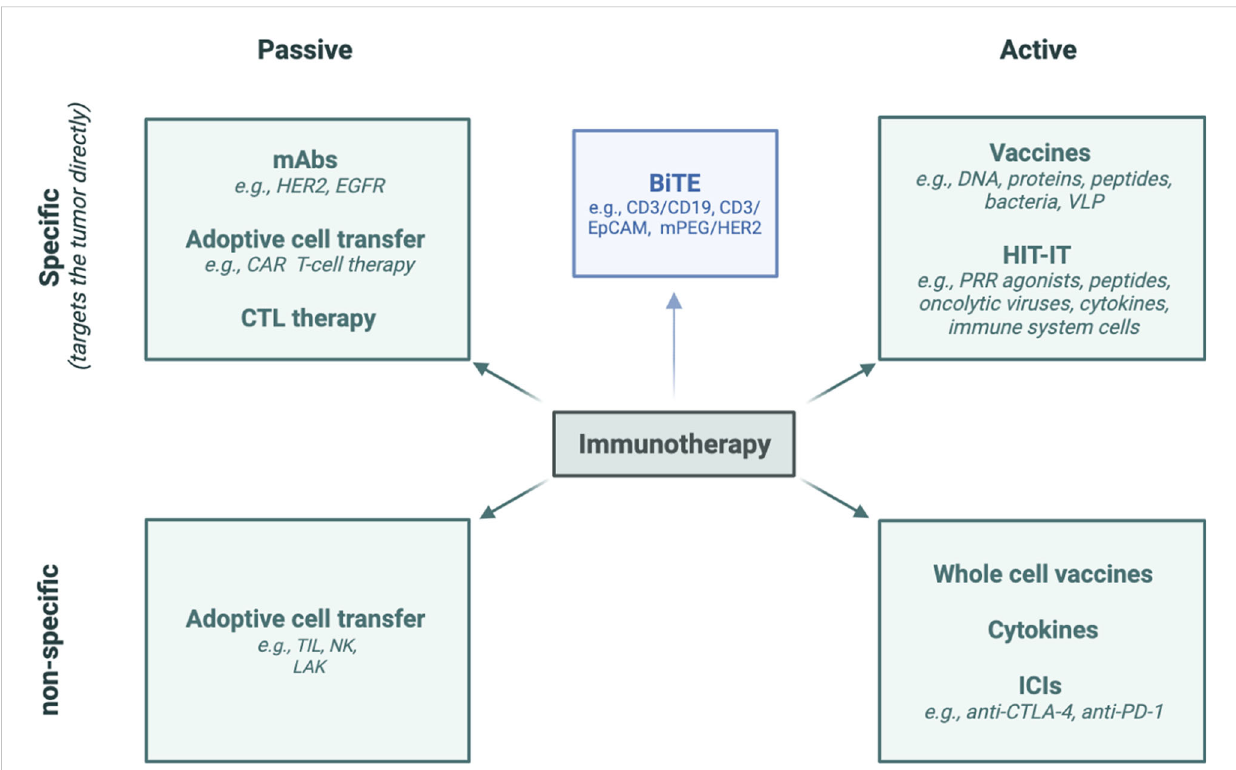
FIGURE 11 Diverse methods of immunotherapy. HER2, human epidermal growth factor receptor 2; EGFR, Epidermal Growth Factor Receptor; CAR, chimeric antigen receptor; CTL, cytotoxic T-lymphocyte; TIL, tumor-in fi ltrating lymphocyte; NK cell, natural killer cell; LAK cell, lymphokine-activated killer cell; BiTE, Bi-speci fi c T-cell engagers; EpCAM, epithelial cell adhesion molecule; DNA, deoxyribonucleic acid; VLP, virus-like particle; HIT-IT, human intratumoral immunotherapy; PRR: pattern-recognition receptor; ICI, immune checkpoint inhibitor; CTLA-4, cytotoxic T-lymphocyte-associated protein-4; PD-1, programmed cell death protein-1; PD-L1, programmed death-ligand